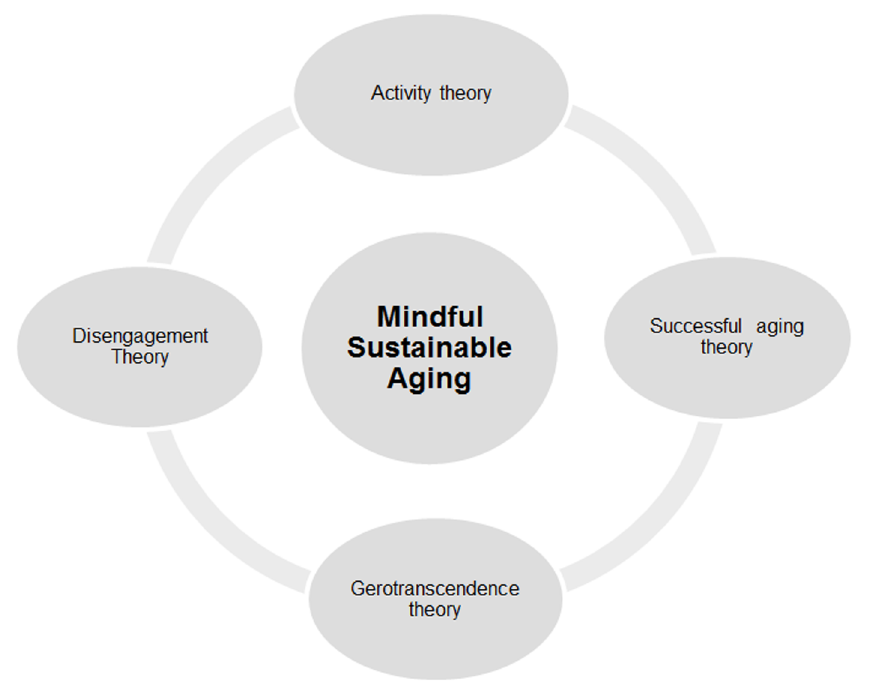
Figure 1. Mindful Sustainable Aging